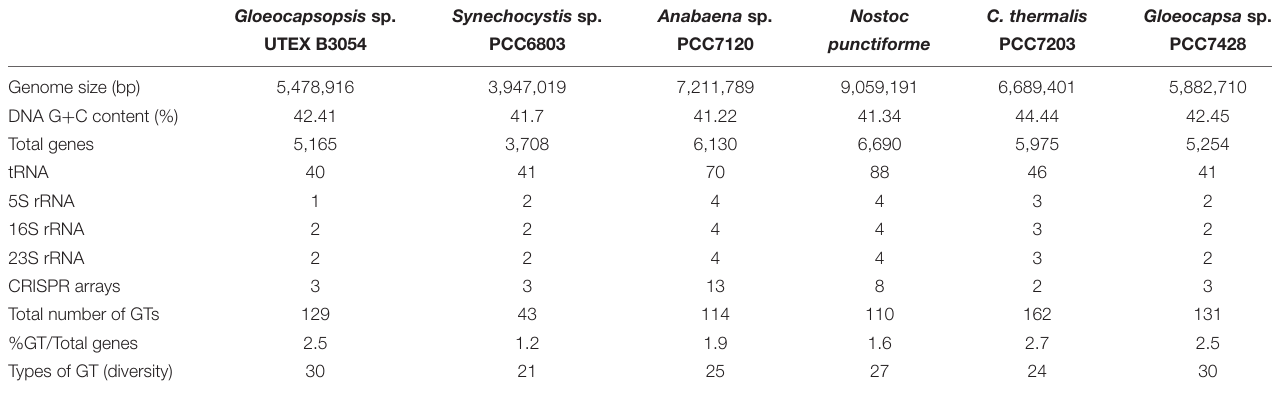
TABLE 1 | General features of Gloeocapsopsis sp. UTEX B3054 and other cyanobacterial genomes. Gloeocapsopsis